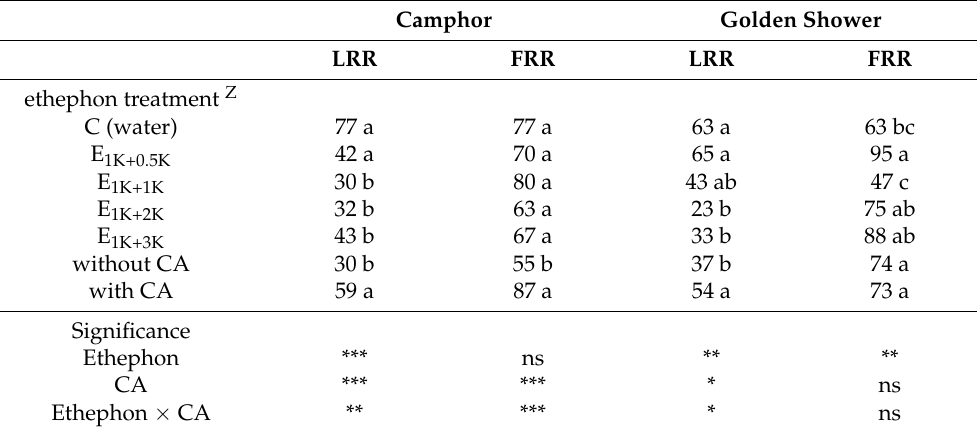
Table 2. LRRs and FRRs of ethephon and/or calcium acetate treatments on camphor and golden shower trees using two-way completely randomized ANOVA. Lowercase letters indicate significant differences among treatments for a given trait ( p < 0.05; LSD test). a, b, and c denote significant differences in performance among treatments. ns, *, **, ***: Non-significant or significant at p < 0.05, 0.01 or 0.001, respectively. Z : Please see Table 1 for treatment descriptions. Camphor Golden Shower LRR FRR LRR